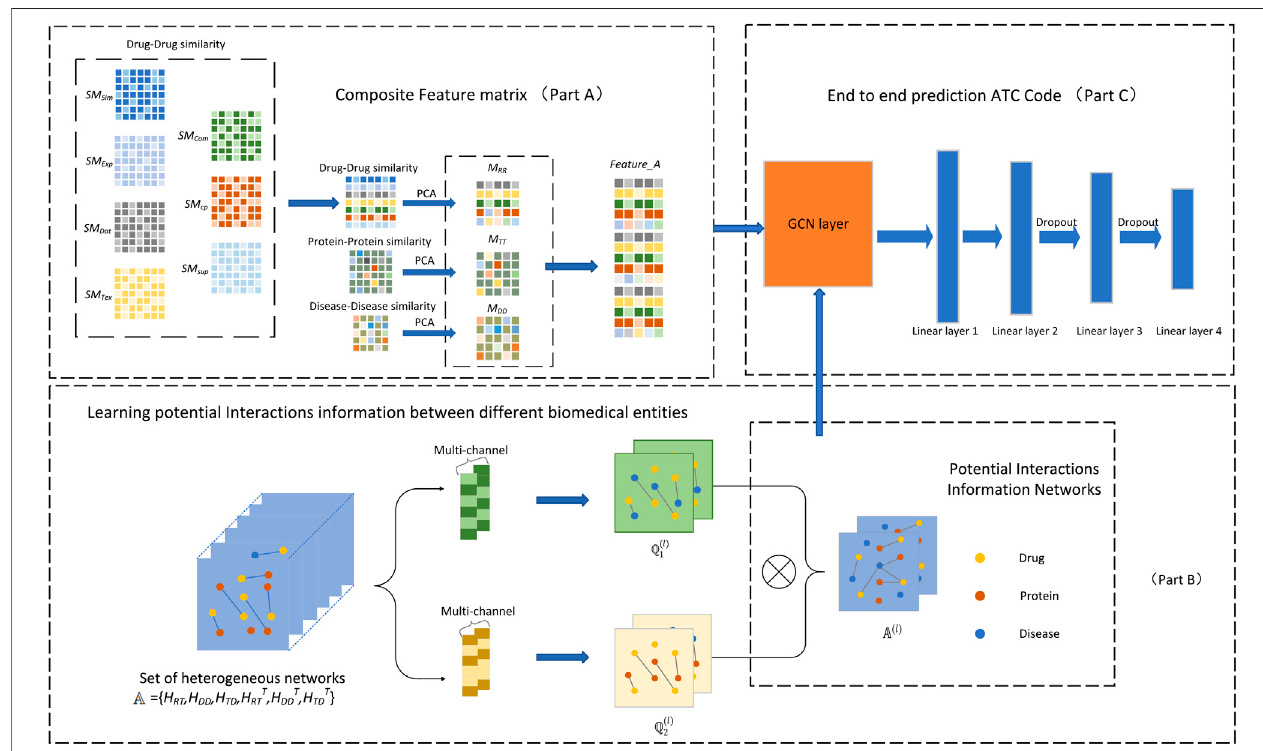
FIGURE 2 | Overall framework of DACPGTN. The feature information of different biomedical entities is integrated to construct a composite feature matrix as the node feature input of the prediction module (Part A). The graph transformer layer is used to obtain the potential interactions information between different biomedical entitiesfromheterogeneousnetworksset(PartB).ThepredictionstageusesthecompositefeaturematrixandthelearnedPotentialInteractionsInformationNetworksto obtain prediction results (Part C).